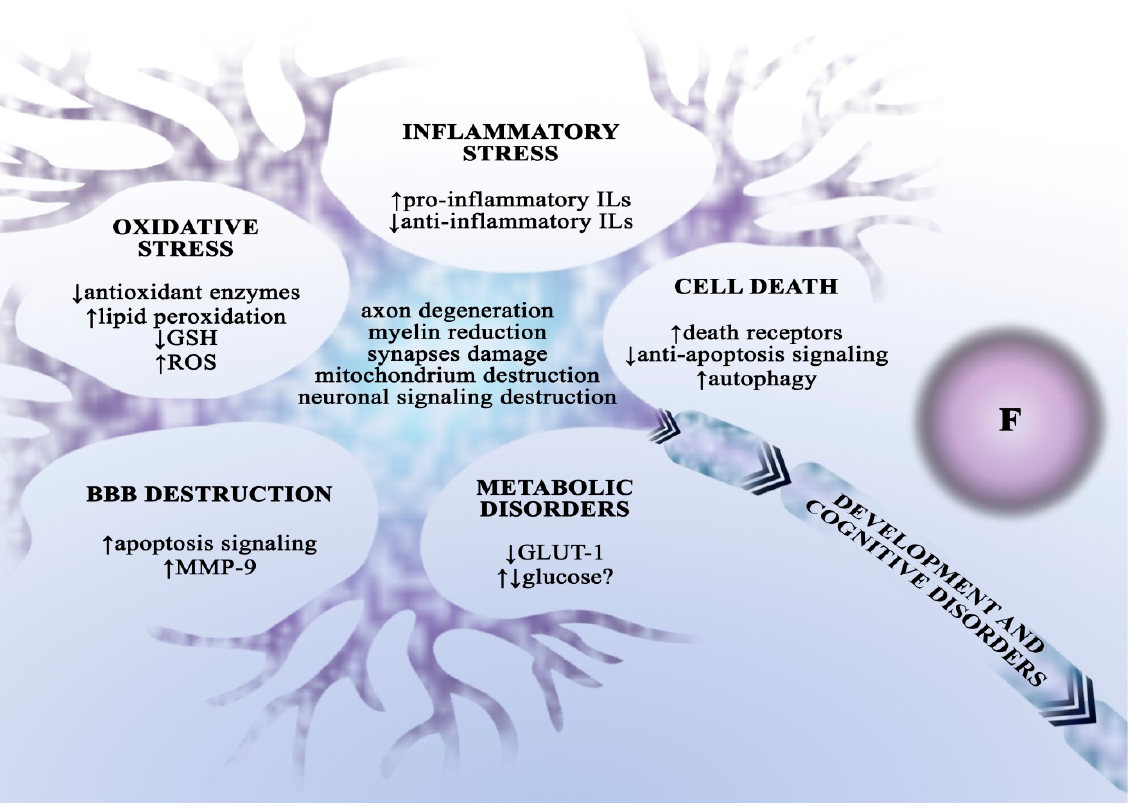
Figure 2. The neurodegenerative effect of fluoride. The toxic effect of fluoride on the central nervous system is multidimensional—it results from disturbances in metabolism regulation, synaptic functioning, the blood–brain barrier integrity, as well as oxidative stress and inflammation induc- tion in neurons and microglia cells. These multidimensional interactions are believed to cause de- velopmental and cognitive impairments in the body. ADHD—attention deficit hyperactivity dis- order; BBB—blood–brain barrier; GLUT—glucose transporter; GSH—reduced glutathione; Ils—interleukins; ROS—reactive oxygen species.